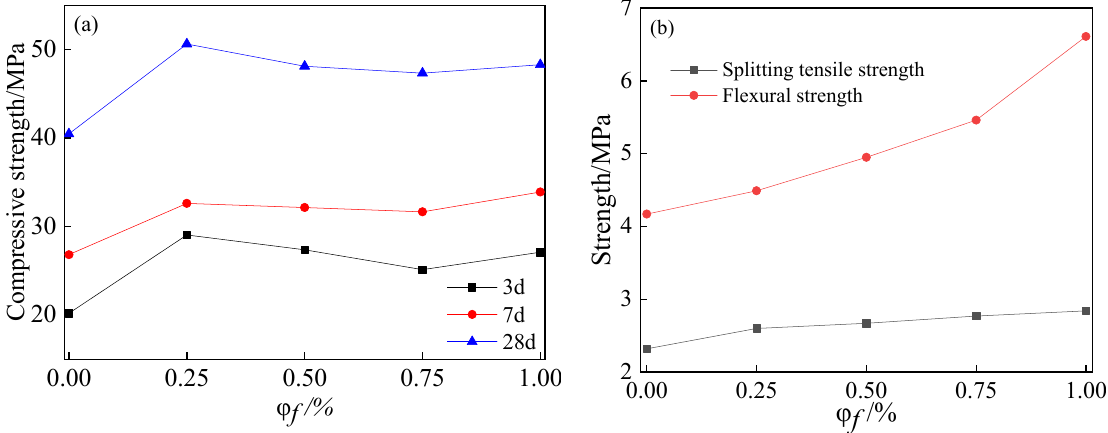
Figure 6. Influence of steel fiber volume fraction ( ϕ f ) on mechanical properties of SCC containing 60% fly ash: ( a ) compressive strength; ( b ) splitting tensile strength and flexural strength.